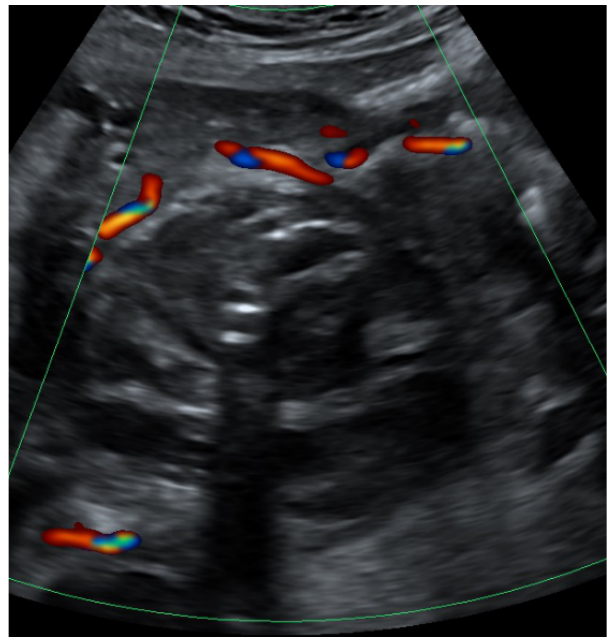
Figure 3. Color Doppler showing the findings 6 days after angiographic coil embolization with absence of intralesional flow, change in echogenicity and regreening of the hematoma. Table 1. Clinical and laboratory parameters .